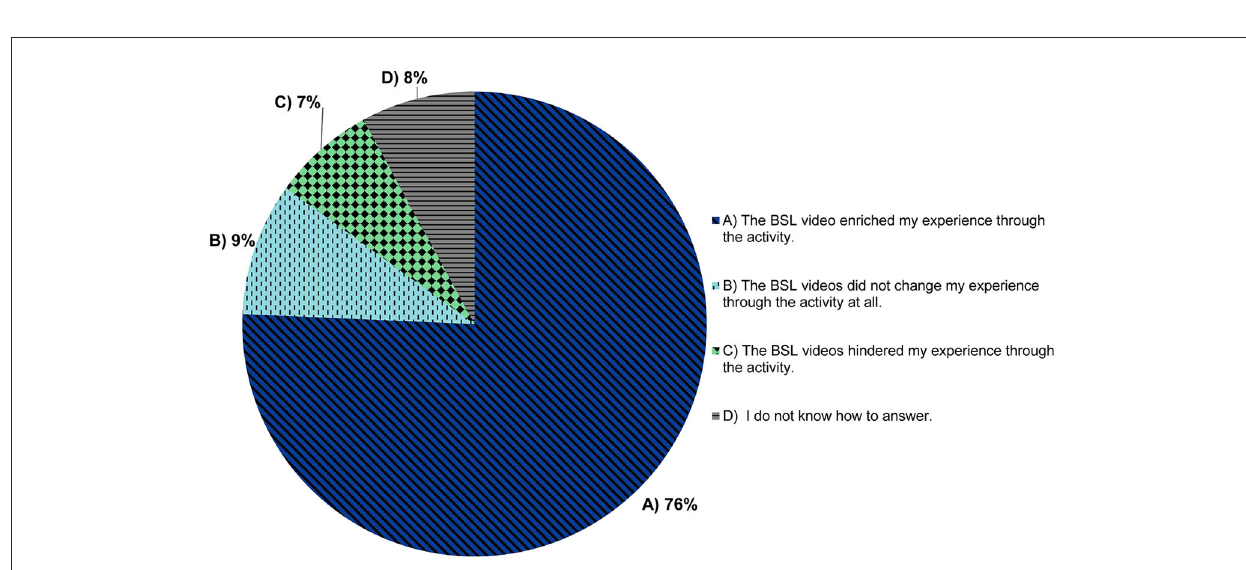
FIGURE3 Percentual data about the video guide experience in the activities n = 745.